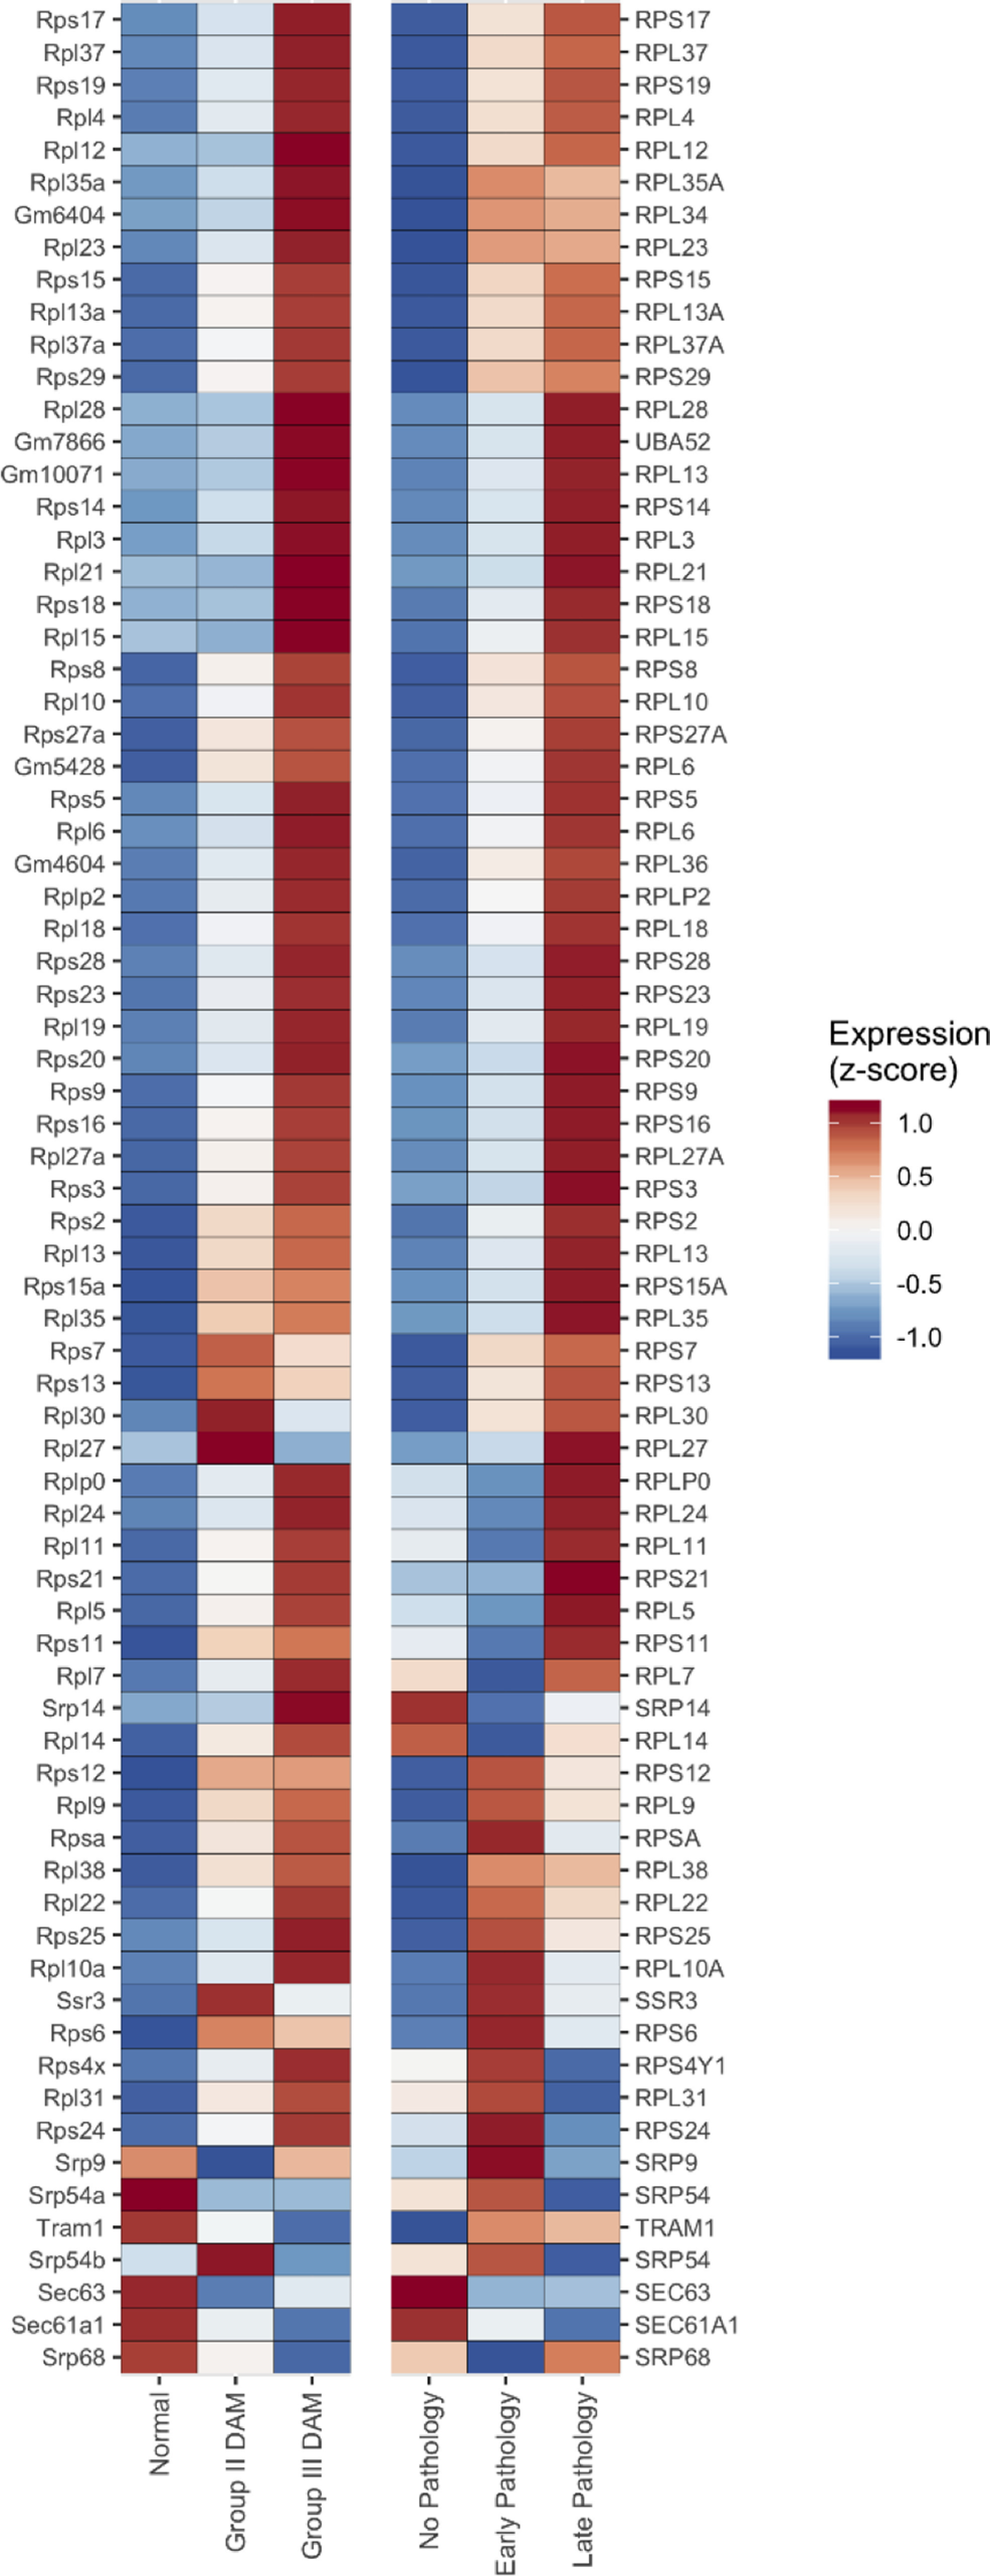
Heatmap of the ER translocation gene expression across three microglia cell clusters from the AD mouse model (left half) and AD pathology subgroups (right half). Expression for each gene is z-scored with high expression in red and low in blue. Genes are ordered based on hierarchical clustering using complete linkage (genes with similar expression across the mouse and human data are clustered together). Three human genes are duplicated because they have two homologous mouse genes (RPL6, RPL13, and SRP54). Human genes without homologous mouse genes are not displayed. Complete results spanning all GO groups are available as Extended Data Figure 3-1 (AD mouse model) and Extended Data Figure 3-2 (AD pathology subgroups). Data from other cell types in the AD pathology subgroups for the ER translocation genes are available in Extended Data Figure 3-3.